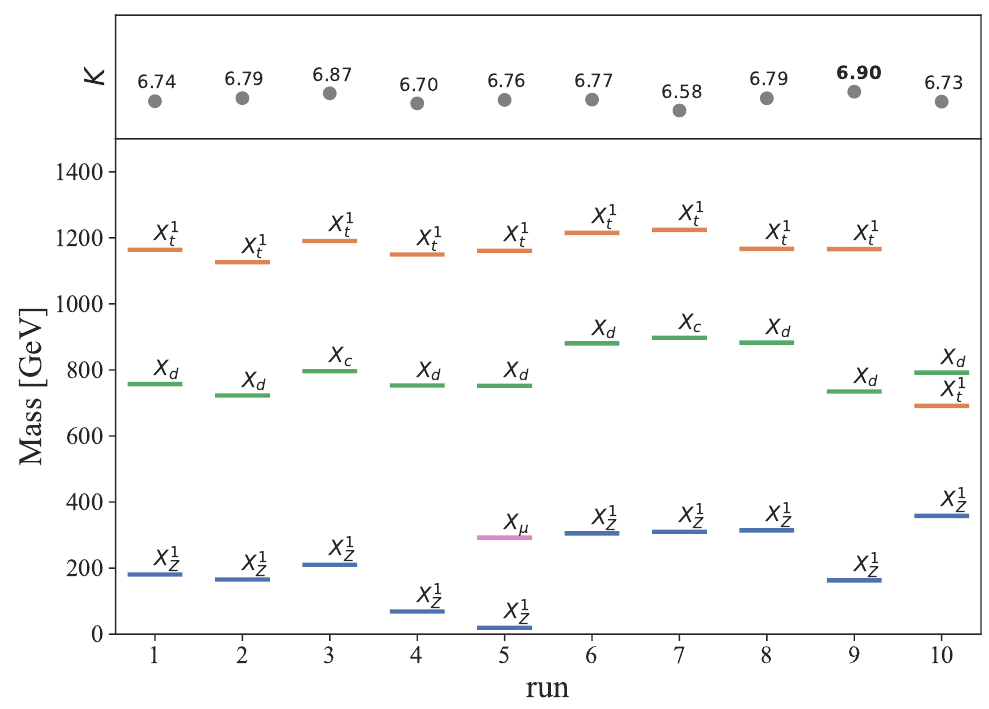
Figure 8 . Particle content and masses for the proto-models with highest test-statistic K obtained in each of the 10 runs performed over the real database. The corresponding K values are shown at the top. Note that for all practical purposes X